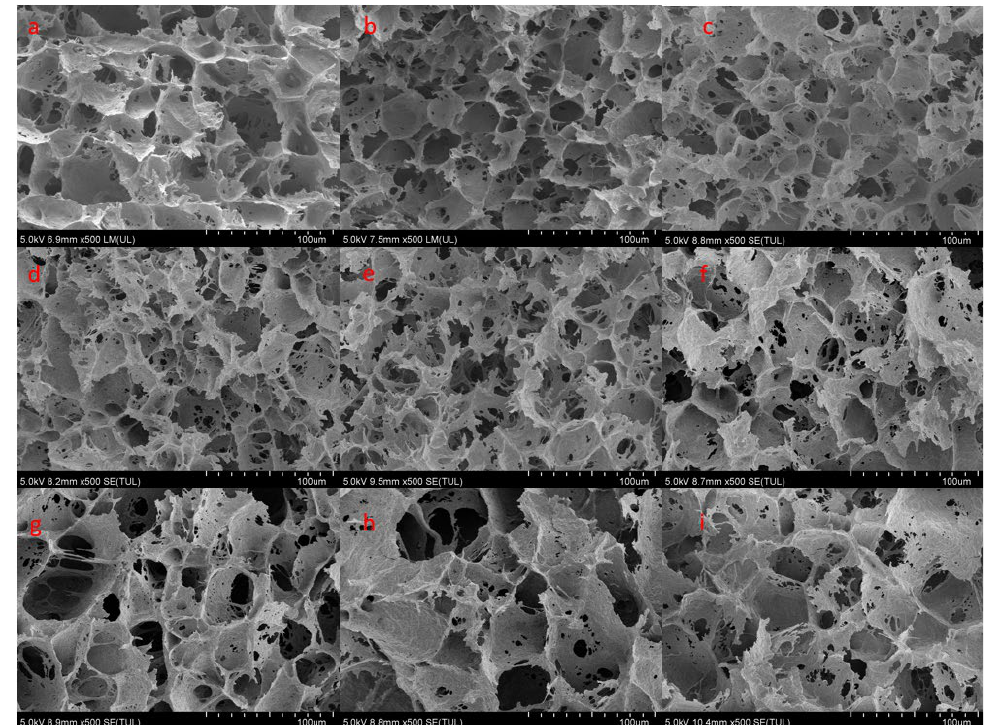
Figure 4. a-i are SEM images (×500) of MP gels with different additions of SCF and ICF. ( a ) Control group, ( b – e ) 2.5–10% SCF, ( f – i ) 2.5–10%